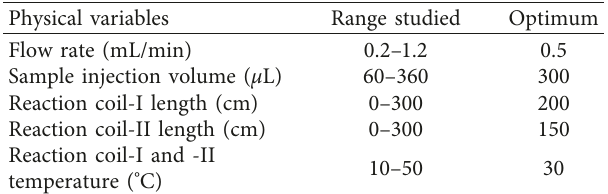
Table 1: Effect of physical variables on the determination of ANTU ( n �